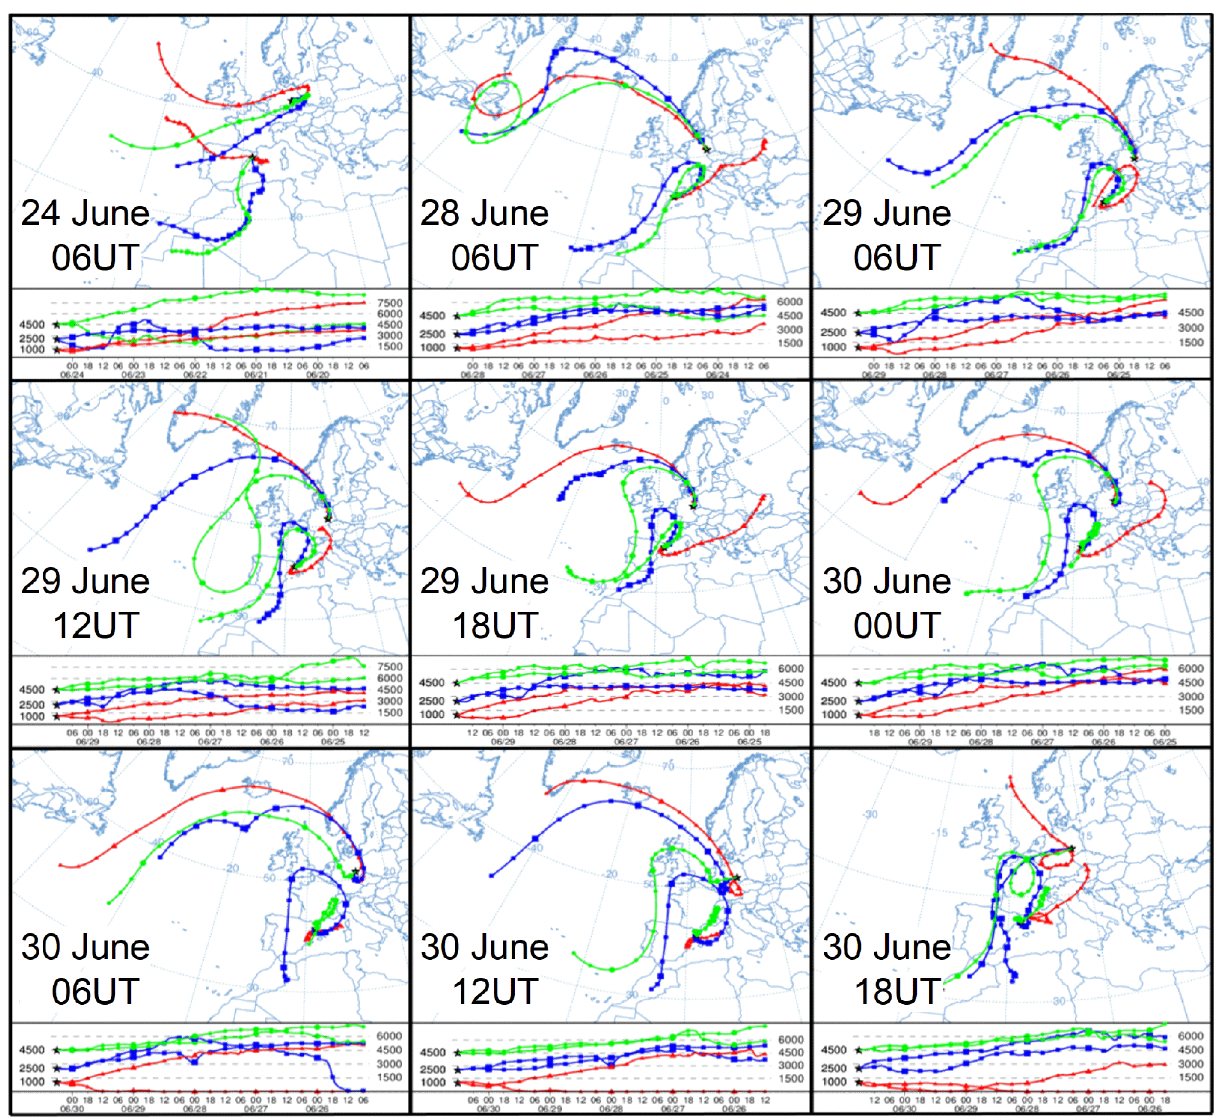
Figure 2. HYSPLIT 5d back trajectories arriving at altitudes of 1000 (red), 2500 (blue), and 4500ma . g . l . (green) over BCN (Spain, 41.4 ◦ N 2.1 ◦ E) and LPZ (Germany, 51.4 ◦ N 12.4 ◦ E) (marked by black stars), illustrating the inter-continental Saharan dust outbreak observed from 23 to 30 June 2019. Note that dates and times (UT stands for UTC) are the same as those shown in Fig. 1 (also indicated in each plot).